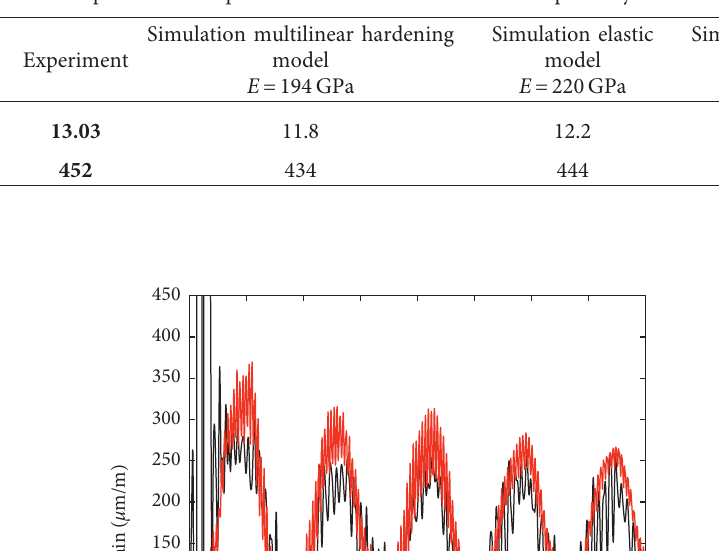
Figure 22: Flexural response for the multilinear model with E � 220GPa with and without Rayleigh damping for shot 128, probed at a length of 154mm on the bottom face of the second specimen. Table 6: Comparison of measured experimental frequencies with numerical results from perfectly elastic and multilinear hardening models.